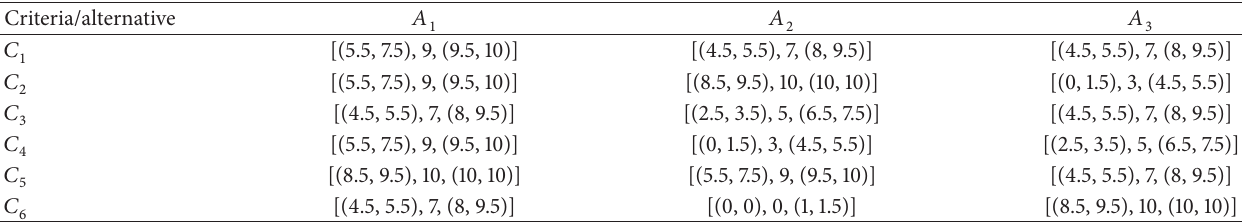
Table 8: Interval-valued TFNs decision matrix.